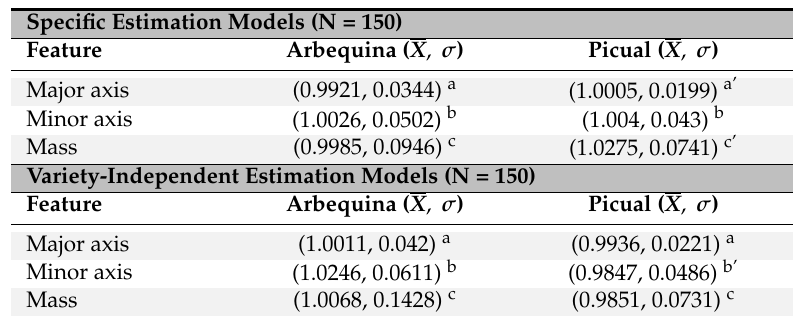
Table 3. Results of one-way analysis of variance performed on the Arbequina and Picual estimations produced by the specific and variety-independent models. The analyzed populations are the individual relative errors (Equation (15)) produced by the different models on the external validation sets of each variety. The mean ( X ) and standard deviation ( σ ) of each population is given. Dissimilar letters indicate different statistical means according to the analysis of variance using the Tukey’s test [25] at p <